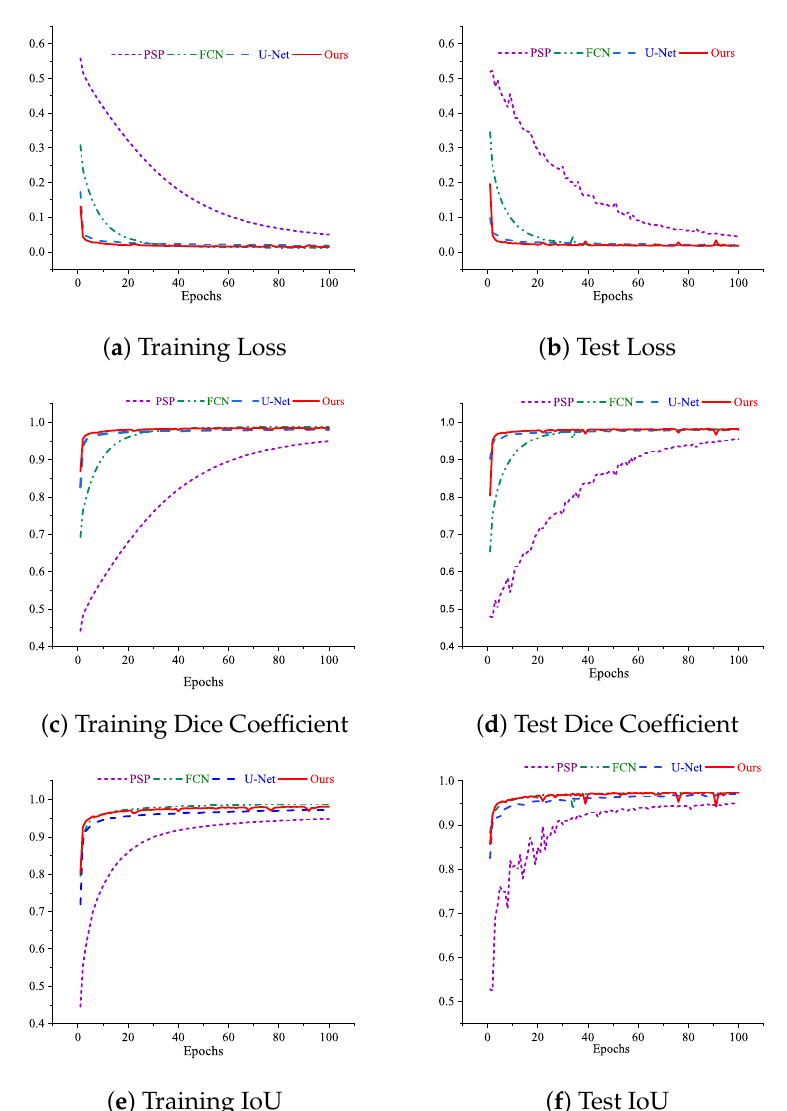
Figure 4. Curves of loss, dice coefficient, and IoU while training and testing the models at 100